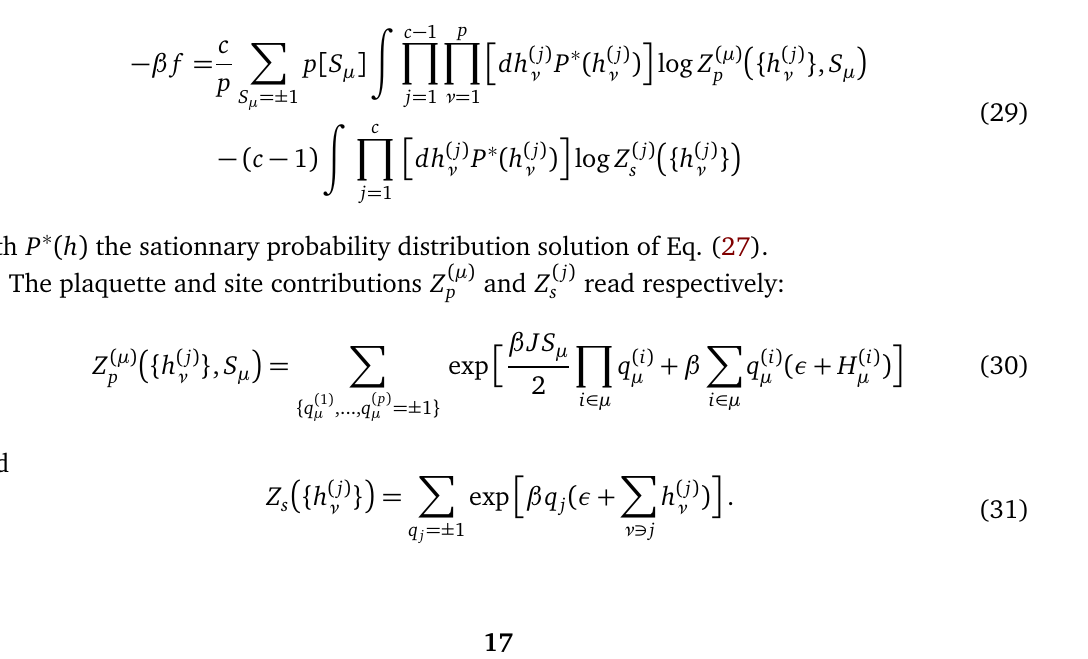
Figure 5: One can merge ( p − 1 )( c − 1 ) sub-trees of N sites either to one plaquette µ or to ( p − p / c ) sites. In the former case, one has a new tree with p ( c − 1 ) N + p sites and in the latter case, ( p − p / c ) trees with cN + 1 sites. We illustrate here the TPM where c = p = 3. Correspondingly, the average free energy per site can be computed as the difference be- tween a “plaquette”( p ) contribution and a “site” ( s )